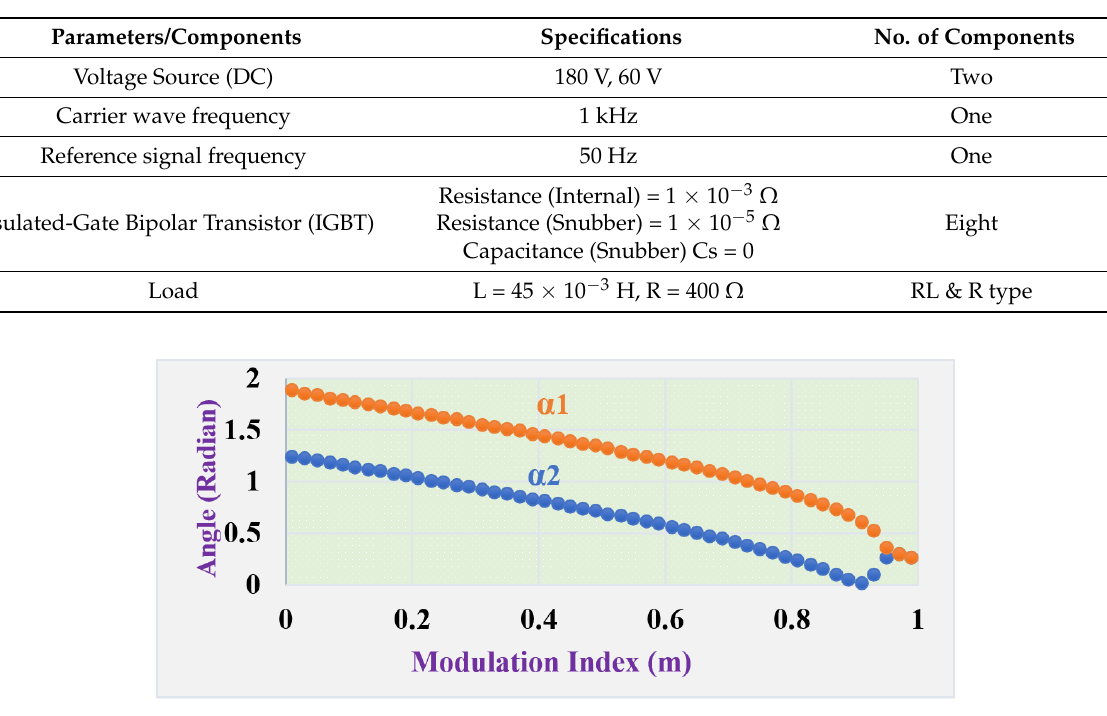
Table 1. Simulation parameters.